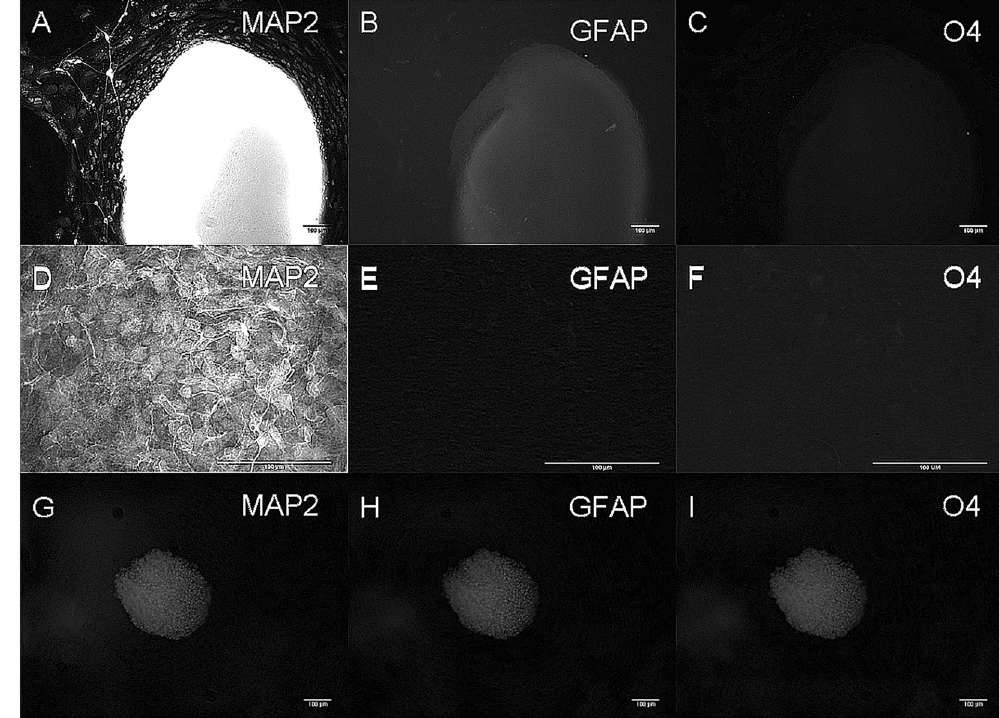
Figure 8. hiPSC-derived aggregates do not express the astrocyte marker GFAP and oligodendrocyte marker O4. ( A – C ) Neural aggregates seeded in fibrin are positive for mature neuronal marker MAP2 but not GFAP or O4. ( D – E ) High magnification image of ( A–C ). ( G–I ) Neural aggregates in genipin-crosslinked fibrin are negative for MAP2, O4 and GFAP. Each image represents a single neural aggregate with an initial seeding density of 4000 cells/aggregate (biological n = 3, technical n =